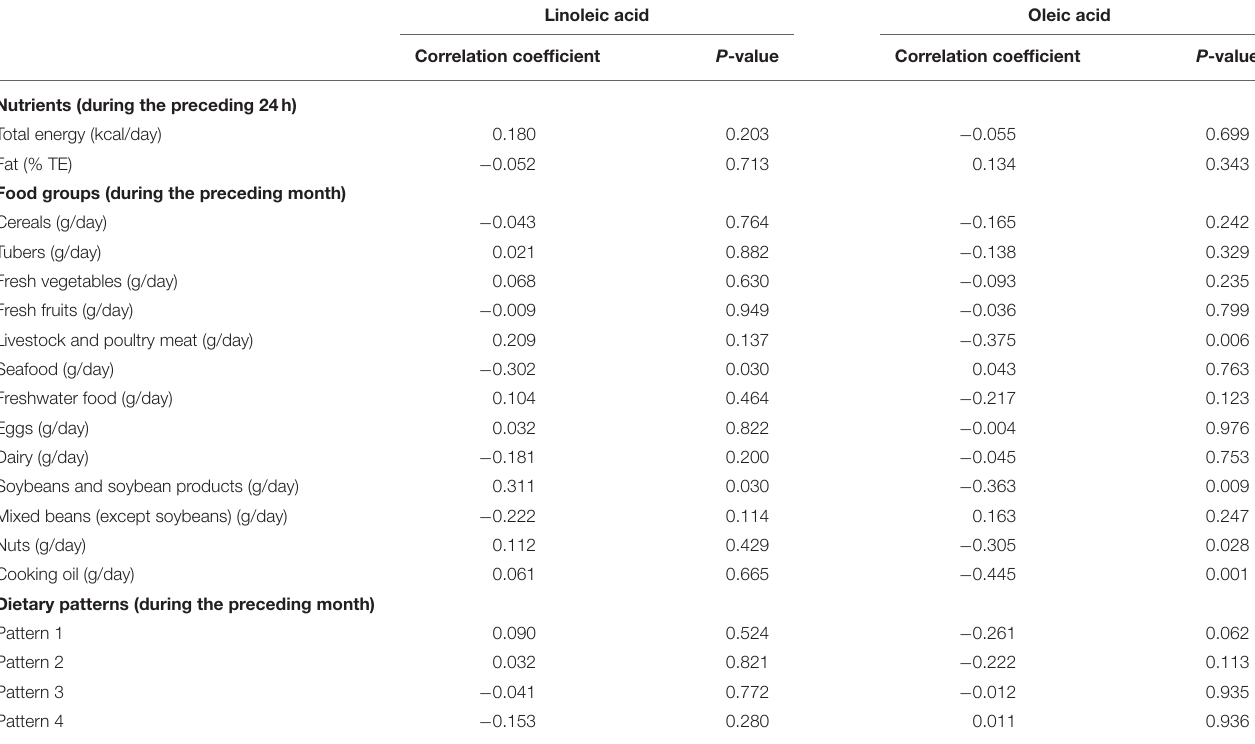
TABLE 5 | Associations of maternal dietary intake with breast milk contents of linoleic acid and oleic acid. Linoleic acid Oleic acid Correlation coefficient P -value Correlation